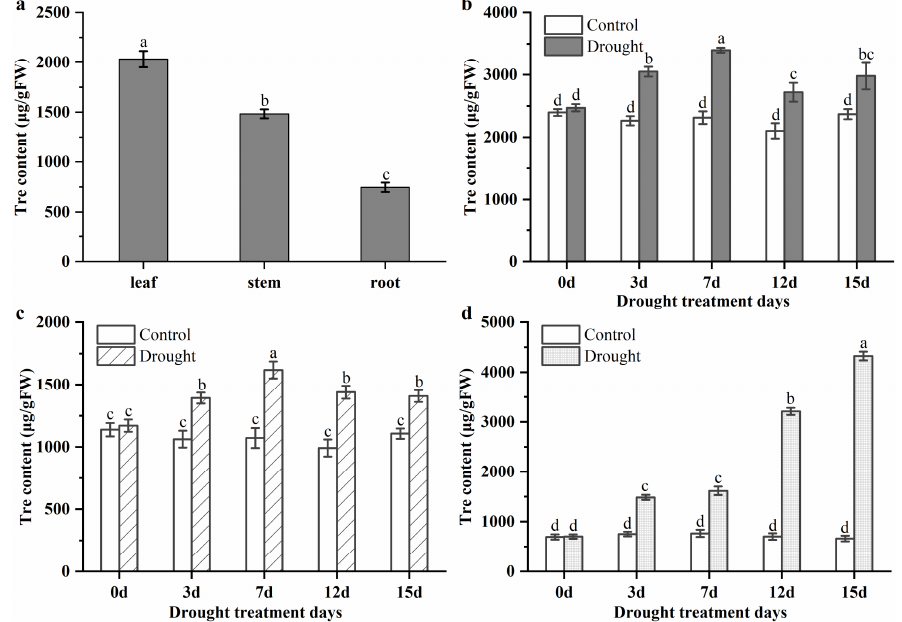
Figure 2. The trehalose content in the tissues ( a ) of Prunus mume and leaves ( b ), stems ( c ), and roots ( d ) in response to drought. Value is the mean of three replicates ± standard error. Lowercase letter represents the significant level.